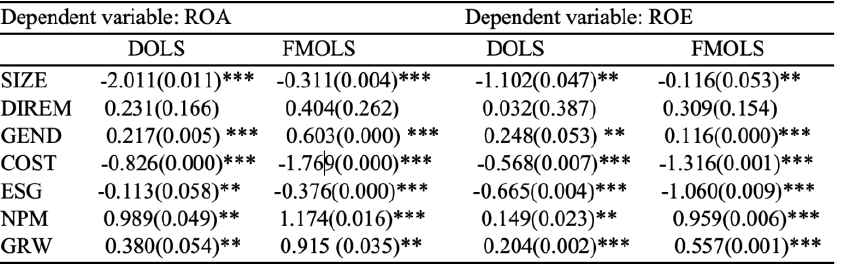
Table 4: Panel DOLS and FMOLS estimation results